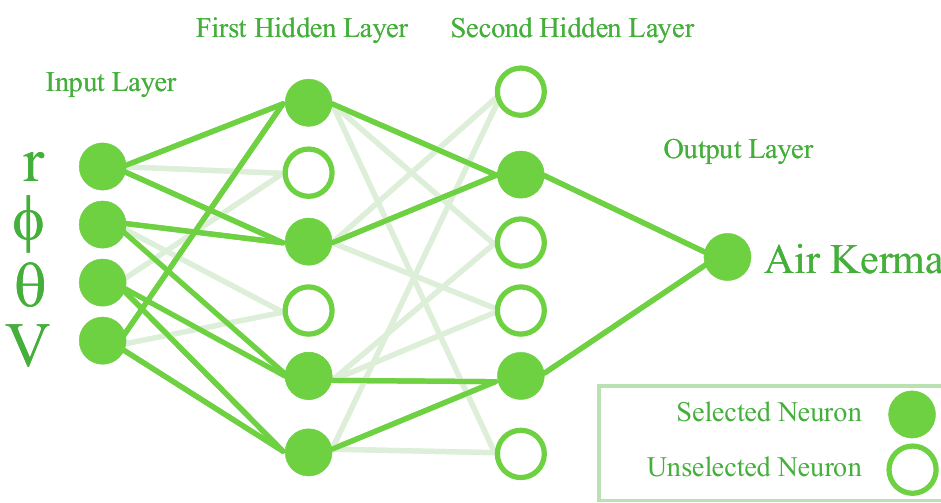
Figure 3. The architecture of the proposed GMDH neural